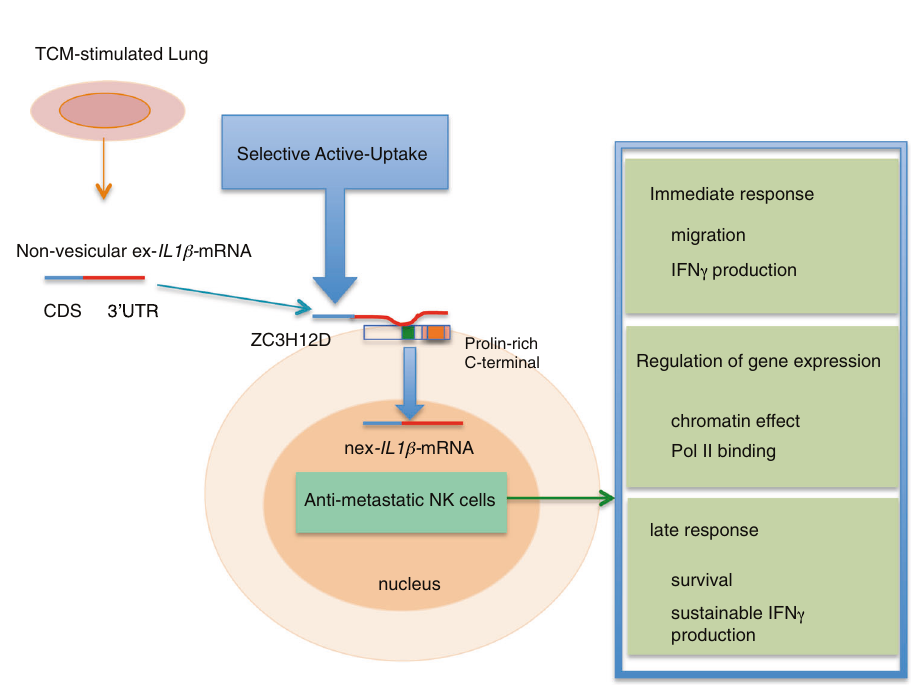
Fig. 8 Model of the translation-independent function of nex-mRNA. The tumor-associated nex- IL1 β - mRNA 3 ′ - UTR was trapped by ZC3H12D protein on the NK cell surface and introduced to the nucleus via its C-terminal containing a proline-rich domain. Then, this may regulate antiapoptotic gene expression associated with RNA Pol II and control NK cell migration, survival, and sustainability of IFN- γ